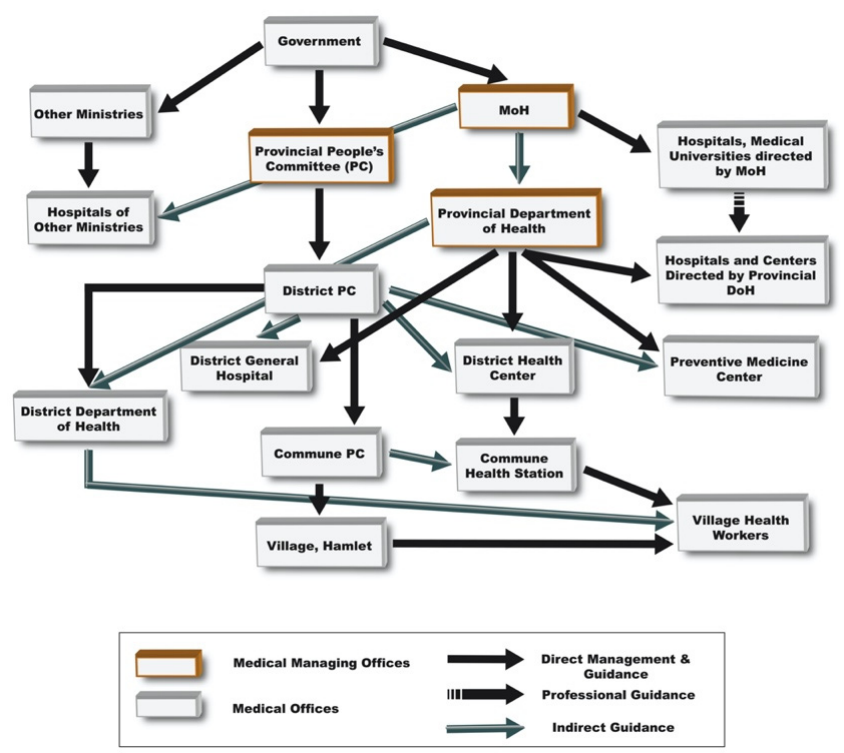
Figure 1. Management and funding of health facilities in Vietnam.